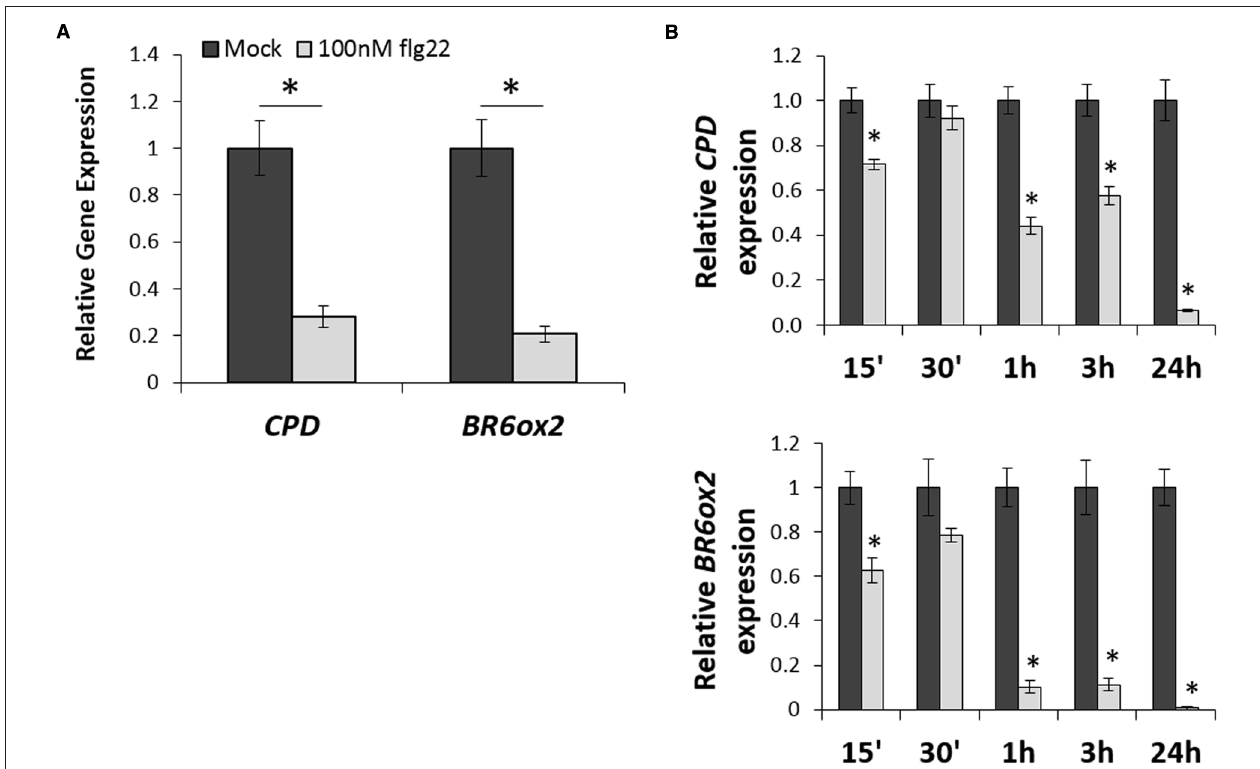
FIGURE 1 | Flg22 treatment downregulates expression of BR biosynthetic genes. (A) . Relative expression of the BR biosynthetic genes CPD and BR6ox2 following treatment with flg22, as measured by qPCR. Ten-day-old seedlings (Col-0 wild-type) were submerged in a 100 nM flg22 or mock solution for 1 h. Bars represent standard deviation, with n = 3. Asterisks indicate a statistically significant difference, according to a Student’s t -test, with p < 0.05. This experiment was repeated three times with similar results; values from one representative experiment are shown. (B) Relative expression of the BR biosynthetic genes CPD and BR6ox2 at different time points following treatment with flg22, as measured by qPCR. Ten-day-old seedlings (Col-0 wild-type) were submerged in a 100 nM flg22 or mock solution and samples were taken at 15 min, 30 min, 1 h, 3 h, and 24 h. Bars represent standard deviation, with n = 3. Asterisks indicate a statistically significant difference, according to a Student’s t -test, with p < 0.05. This experiment was repeated three times with similar results; values from one representative experiment are